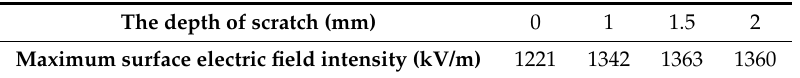
Table 5. Maximum surface electric field distribution with different length of scratches on Φ 1.3 m.